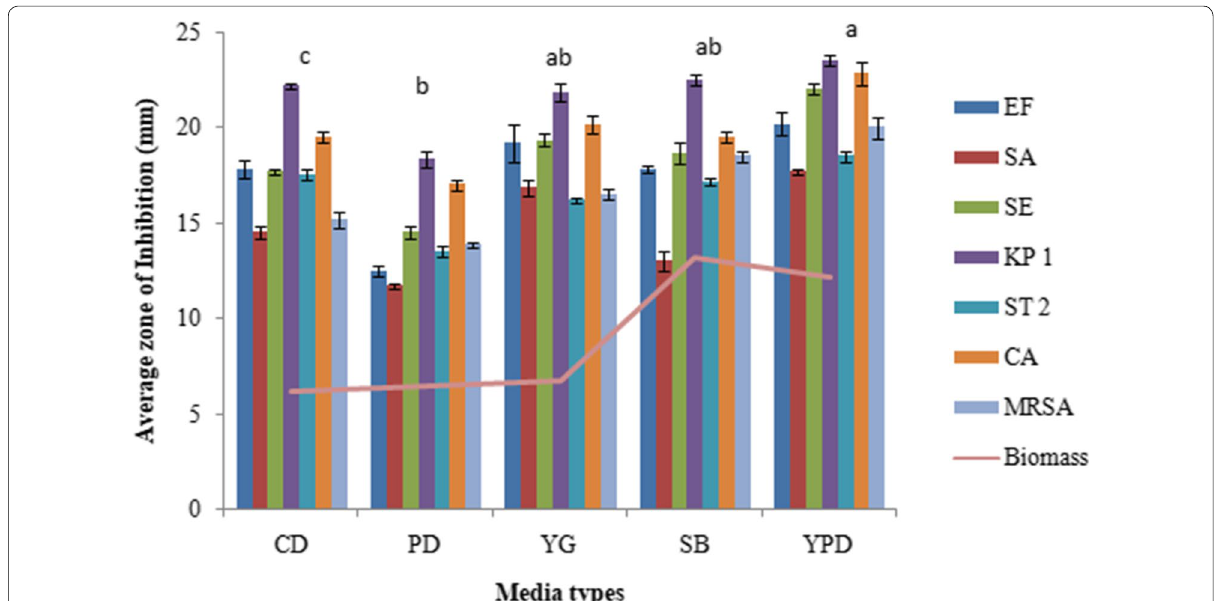
Fig. 2 Effect of different growth media on antimicrobial activity of C. globosum. EF, Enterococcus faecalis; SA, Staphylococcus aureus ; SE, Staphylococcus epidermidis ; KP1, Klebsiella pneumoniae 1; ST2, Salmonella typhimurium 2; CA, Candida albicans MRSA, Methicillin-resistant Staphylococcus aureus. *Values are given as mean SE. Different letters (a to c) between the columns are significantly different (post hoc tukey Test, ± p 0.05) ≤